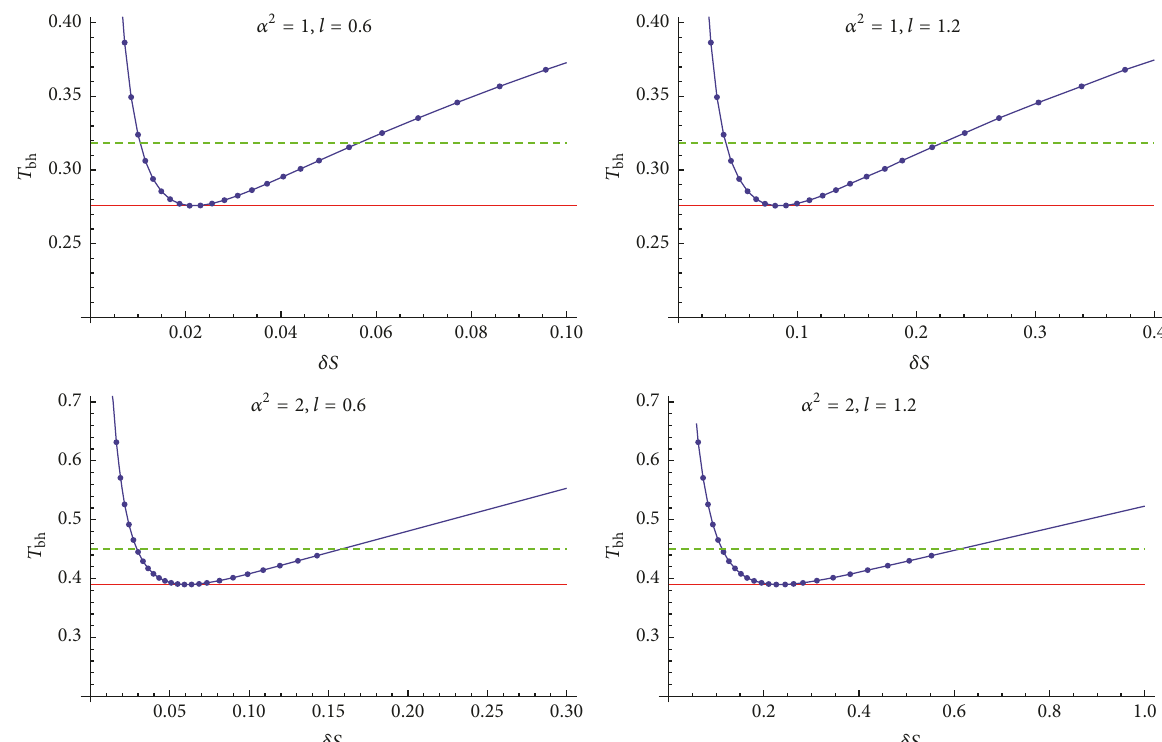
Figure 3: The regularized entanglement entropy versus the black hole temperature. The dashed green line represents the Hawking-Page transition temperature, while the solid red line stands for the minimal